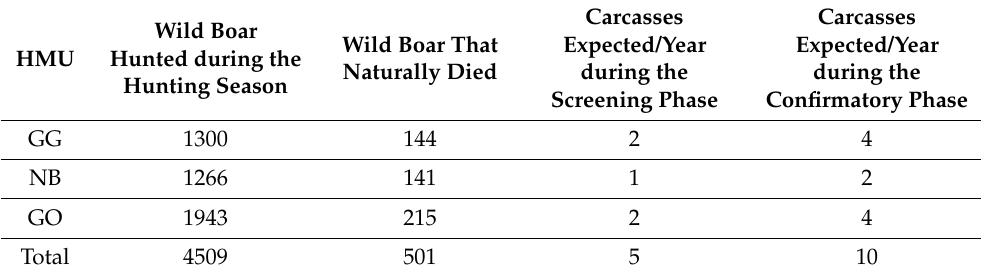
Table 5. Data estimated by the WBC-Counter tool when applying the approach based on the number of wild boar